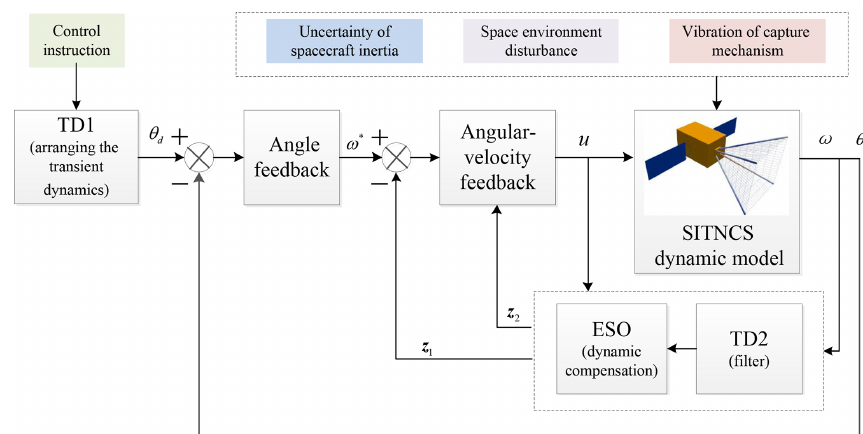
Figure 6. A double-loop controller based on the active disturbance rejection